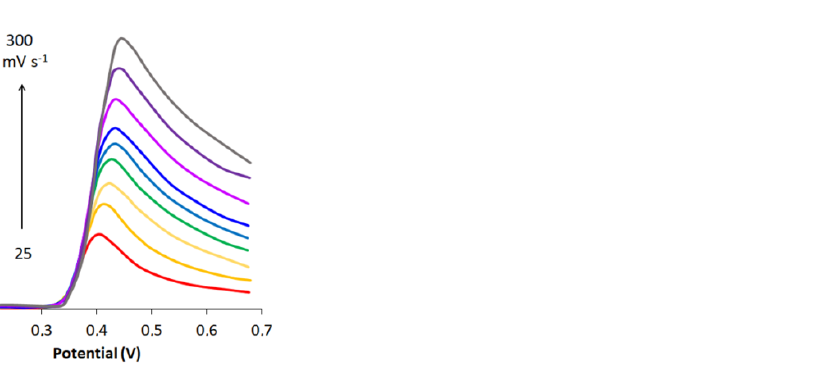
Figure 6. LS voltammograms of 0.01 mM UA on CVE act at 2.0 V in PB pH 6 for different scan rates (25–300 mVs −1 ).